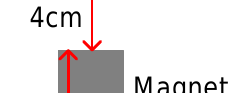
Figure 9. Picture of a FSMSS.